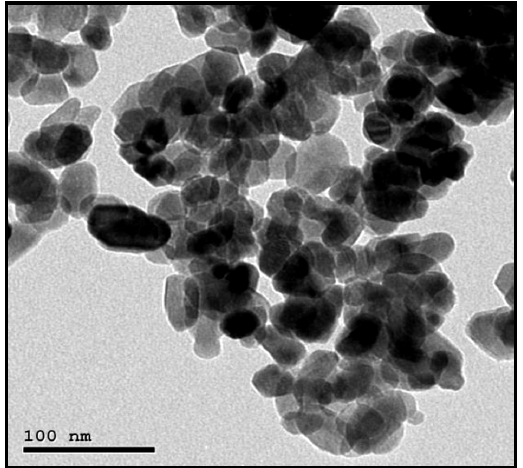
Figure 2. TEM image of ZnO nanoparticles.